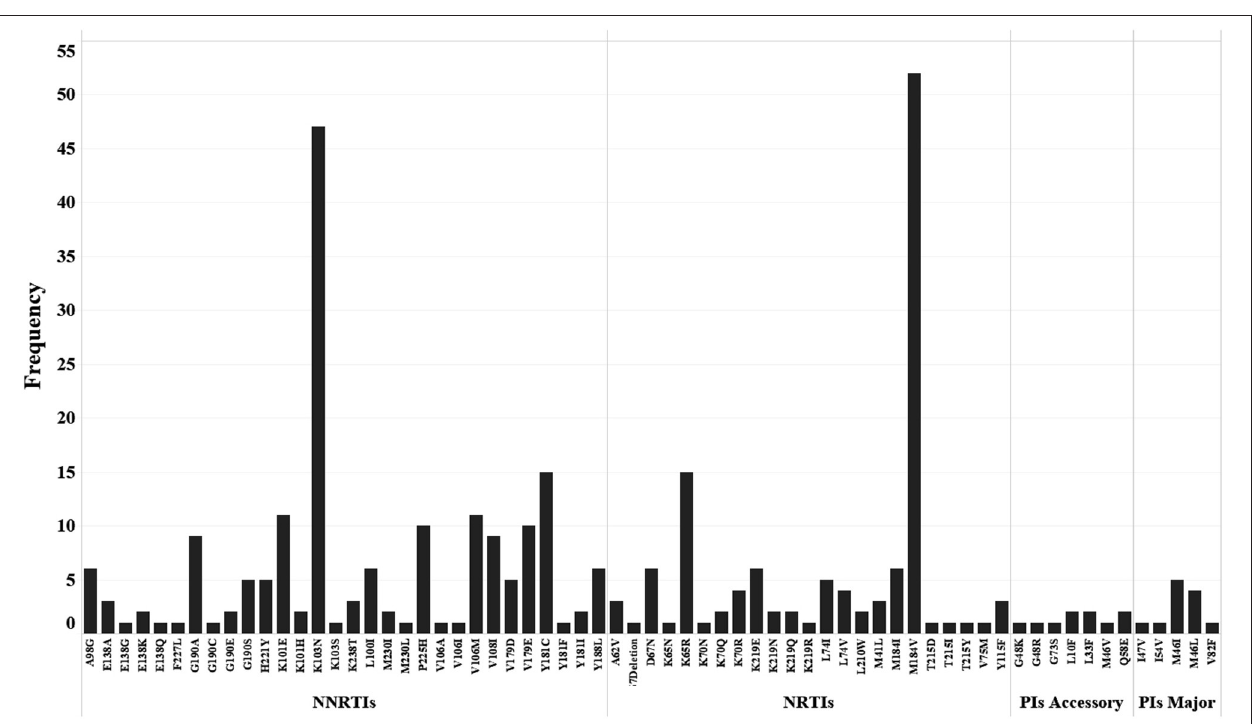
FIGURE 4 | Distribution and frequency of drug resistance mutation sites to NNRTIs, NRTIs and PIs (Major and